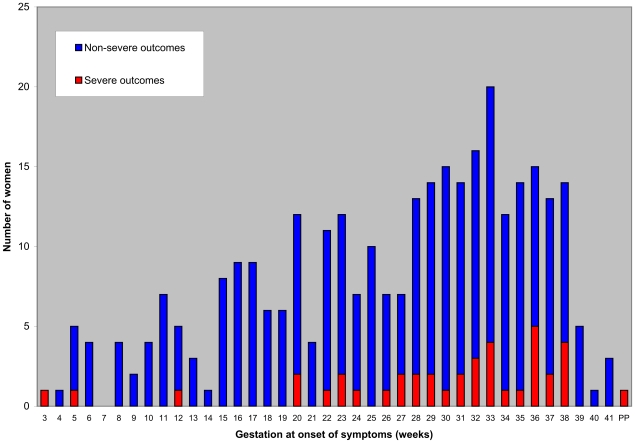
Gestational age at onset of symptoms according to the severity of symptoms.